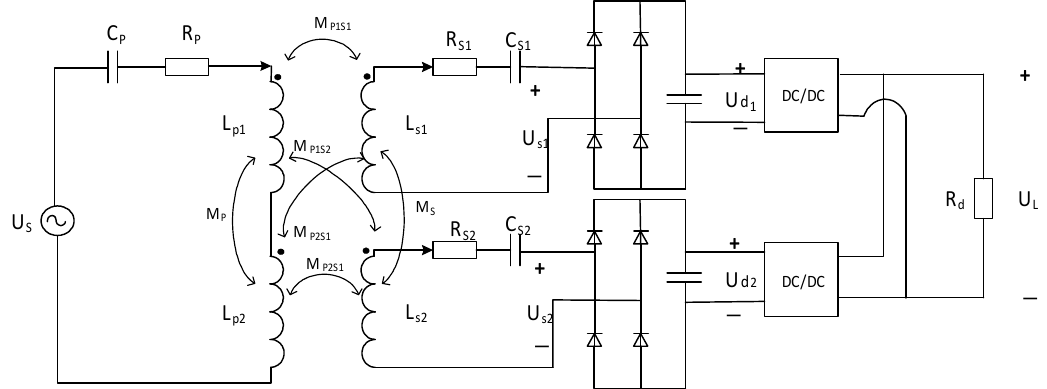
Figure 5. Circuit diagram of the MIMO system.